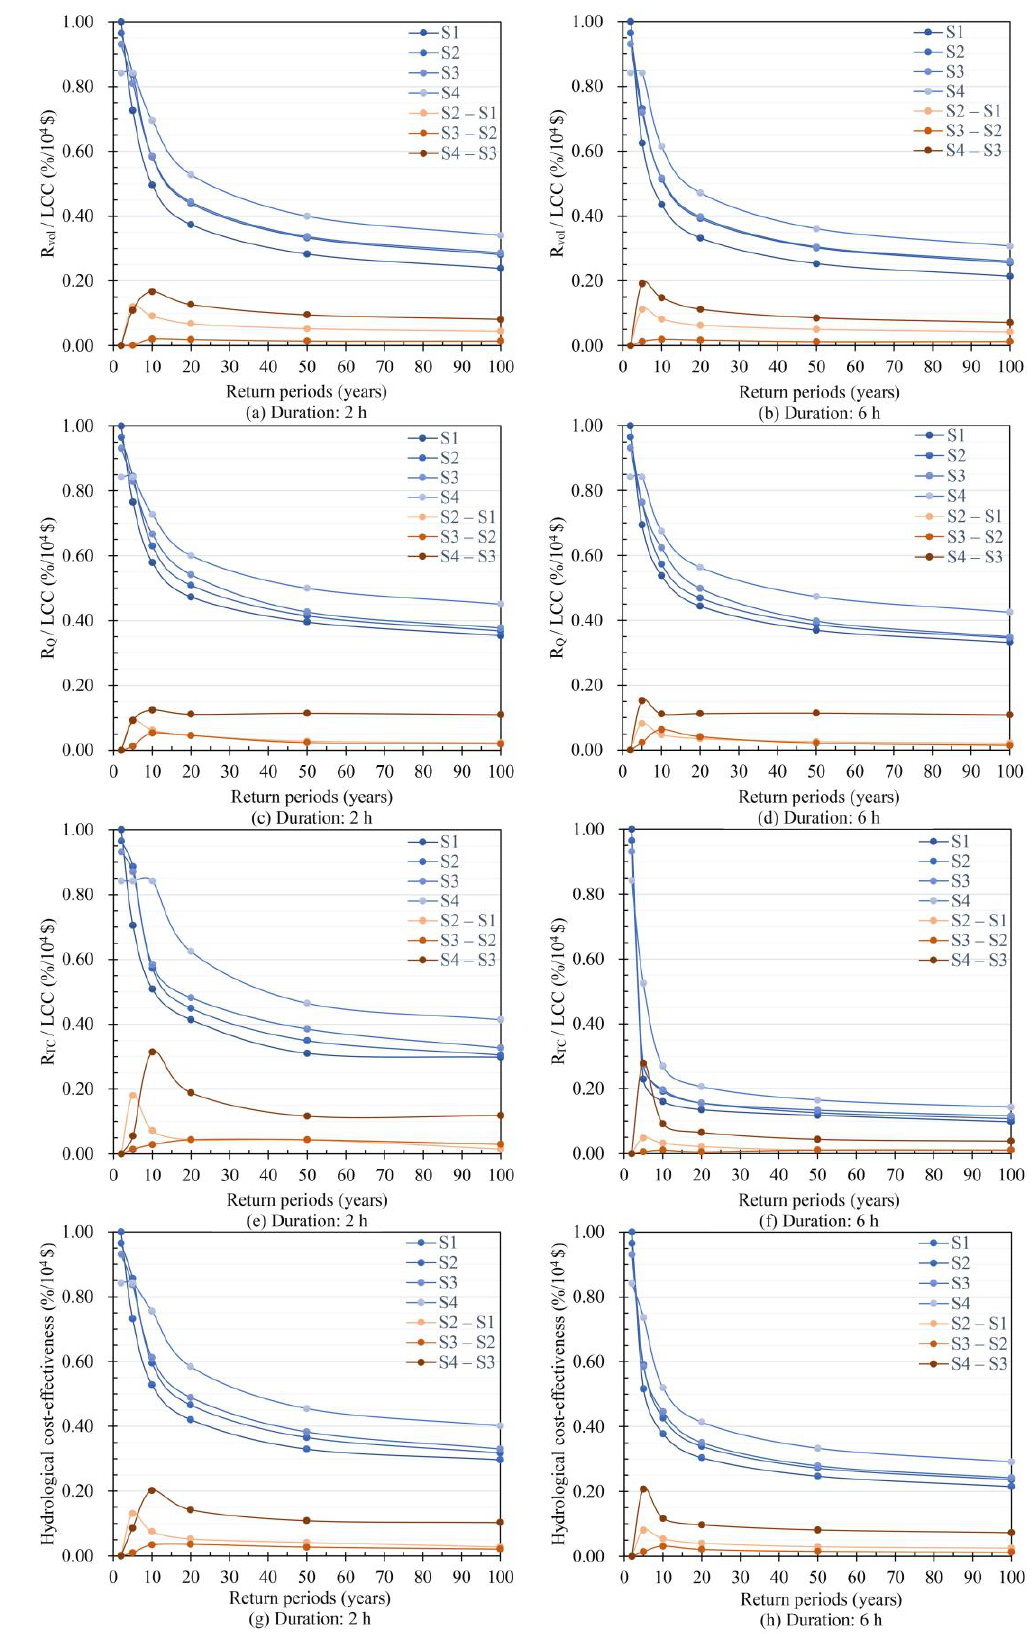
Figure 12. Assessment of 𝑅 𝑉𝑜𝑙 /LCC ( a , b ), 𝑅 𝑄 /LCC ( c , d ), 𝑅 𝑇𝐶 /LCC ( e , f ), and hydrological cost- effectiveness ( g , h ) for S1, S2, S3, and S4 as responses to various return periods and rainfall dura- tions.